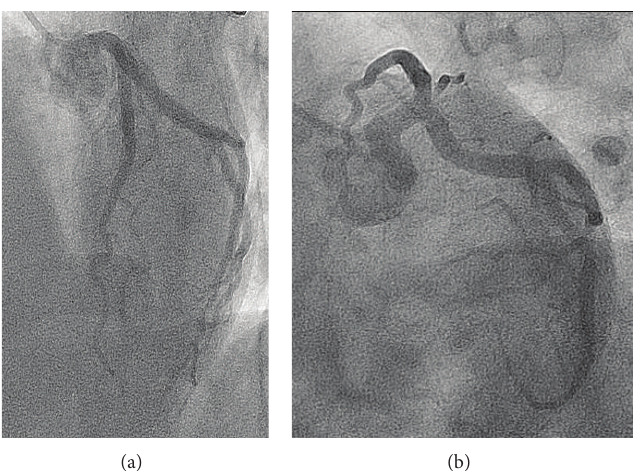
Figure 1: LCA, with the “short” LAD artery coursing through the proximal part of the AIVS. (a) LAO cranial view. (b) LAO caudal “spider” view. LCA, left coronary artery; LAD, left anterior descending artery; AIVS, anterior interventricular sulcus; LAO, left anterior oblique.